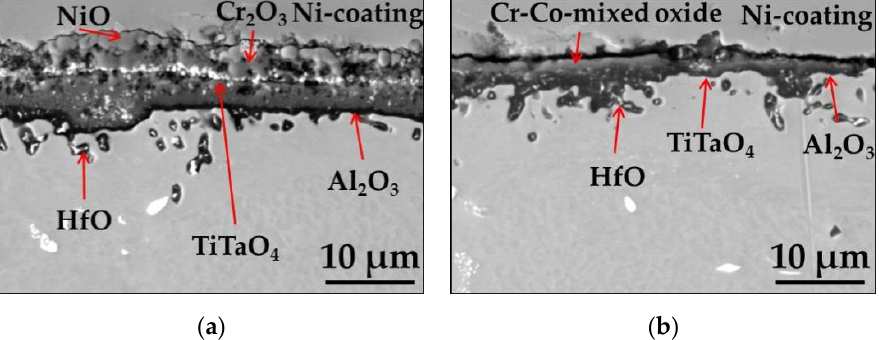
Figure 7. SEM/BSE images performed on cross-sections of Mar M 247 after rapid cyclic oxidation test at 1000 °C after 360 cycles with: ( a ) Polished surface; ( b ) Ground surface.